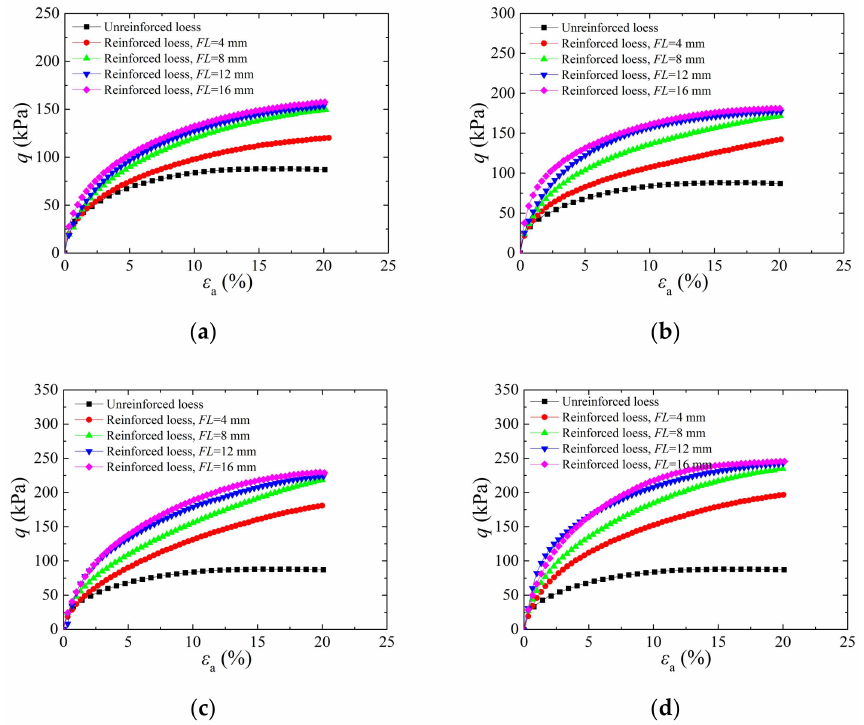
Figure 4. Effect of fiber length on stress–strain curves under 50 kPa cell pressure: ( a ) FC = 0.2%; ( b ) FC = 0.4%; ( c ) FC = 0.6%; ( d ) FC =